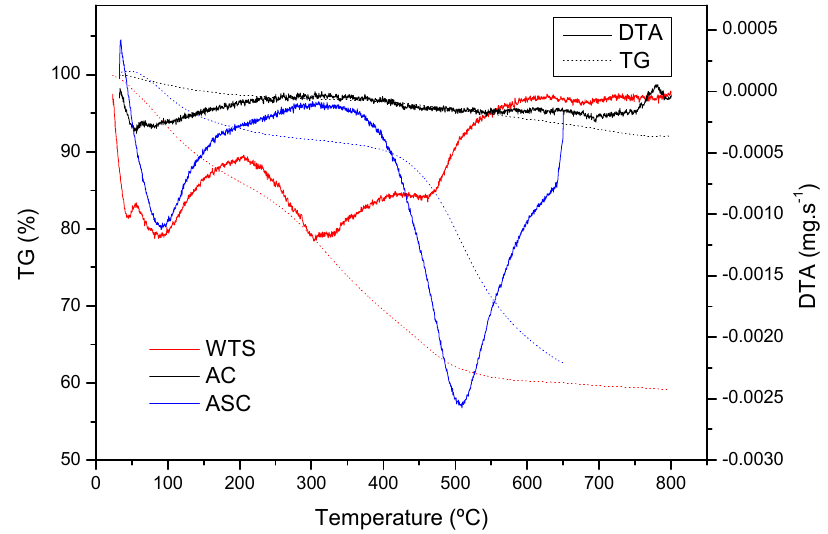
Figure 2. Thermalgravimetric curves.